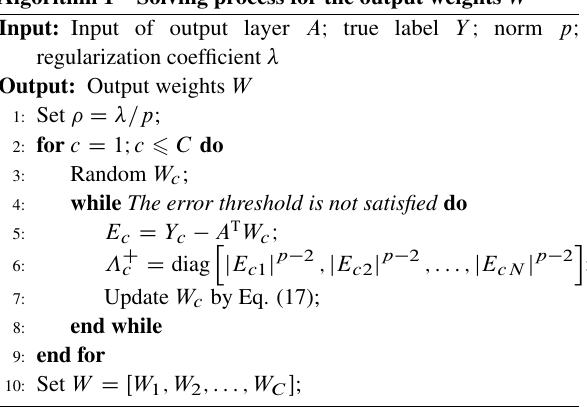
Algorithm 1 Solving process for the output weights W